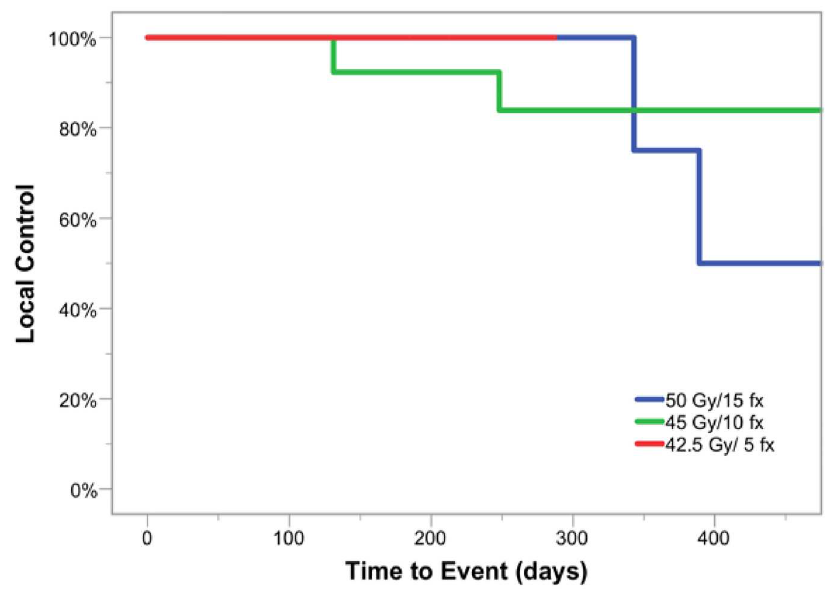
Fig 2. Estimated local recurrencefree survival by fractionation cohort.